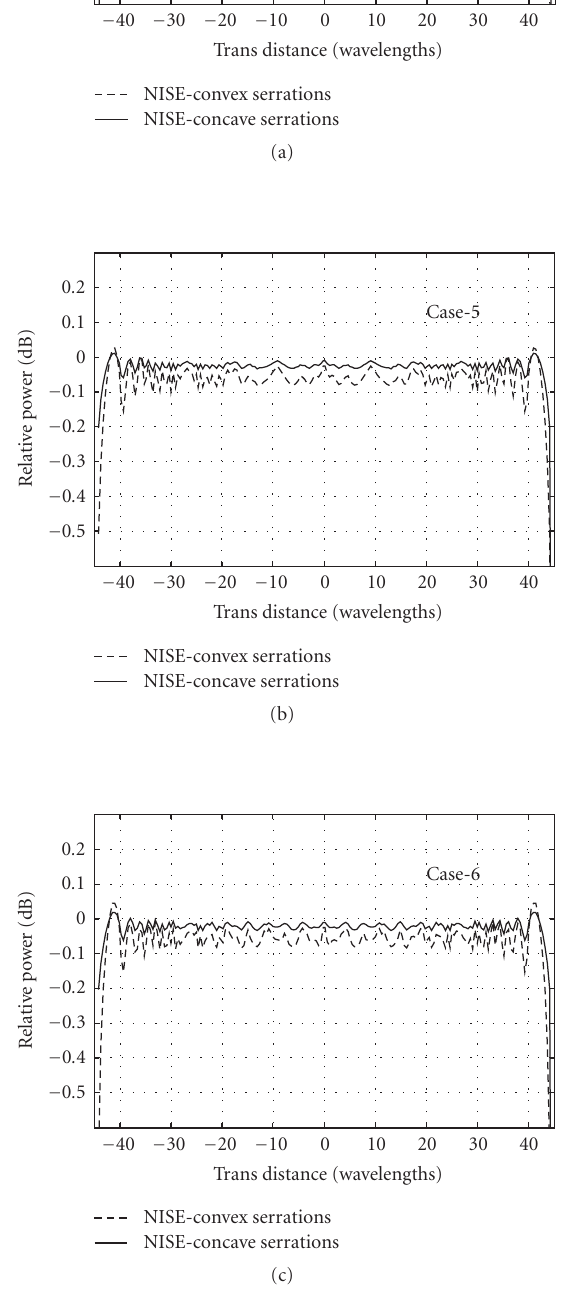
Figure 6: Fresnel-zone field for 90 λ × 90 λ NISE-convex and NISE- concave serrated CATRs for cases 4, 5, and 6.